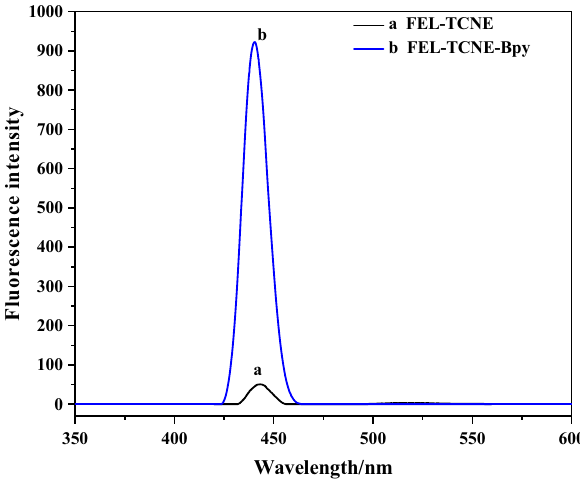
Figure 3: Infrared spectra of FEL – TCNE – Bpy